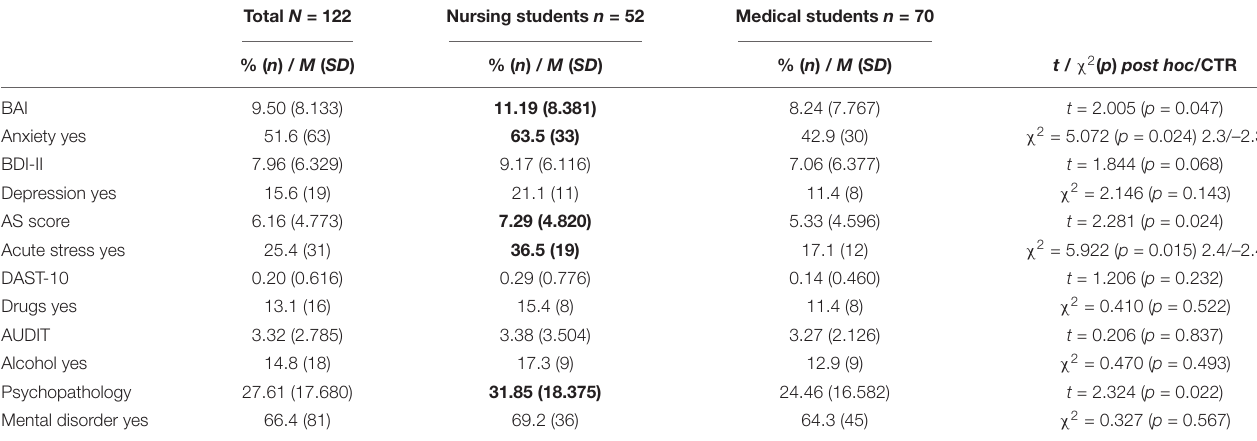
TABLE 3 | Psychopathology in students.